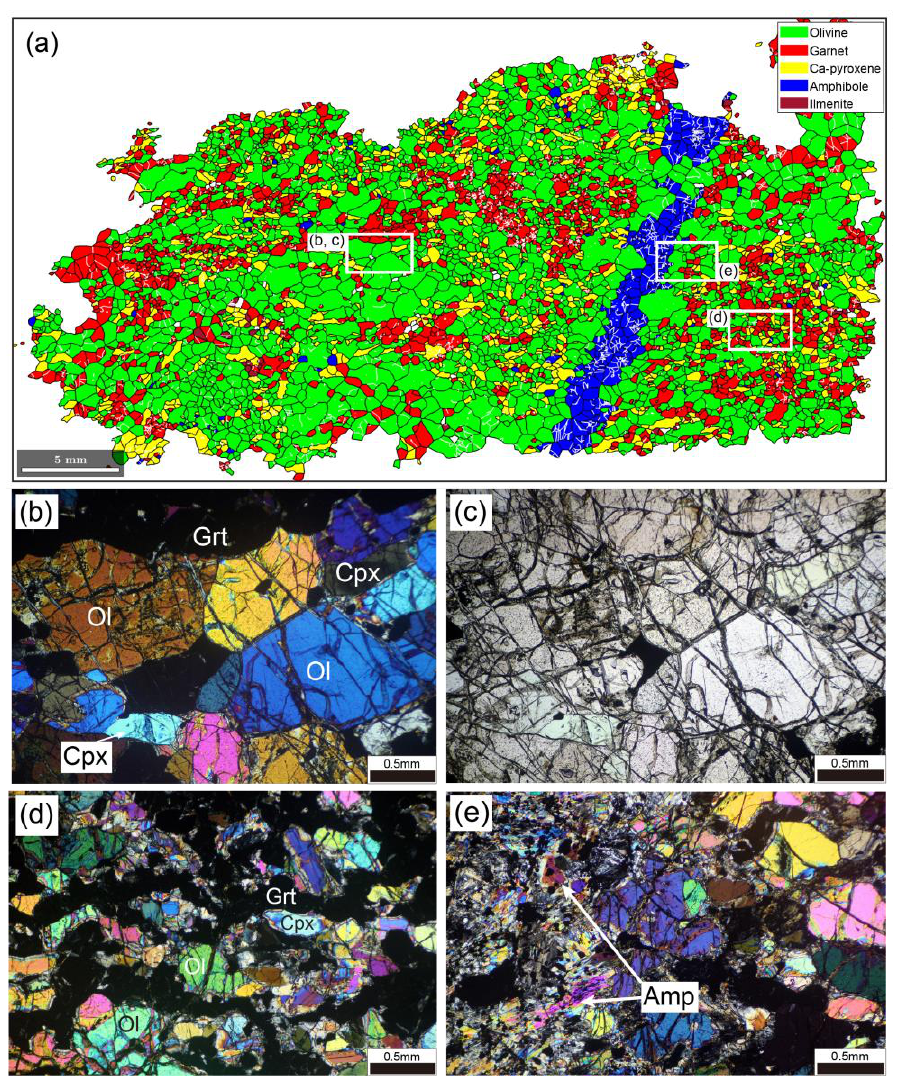
Figure 4. Microstructures of garnet peridotite. ( a ) EBSD phase map of entire thin-section. White areas in the map are non-indexed pixels. White lines represent subgrain boundaries. White rectangles indicate areas shown in ( b – e ). ( b , d , e ) Photomicrographs under cross-polarized light. ( c ) As in ( b ), but under plane-polarized light. Ol, olivine; Grt, garnet; Cpx, Ca-pyroxene; Amp, amphibole.